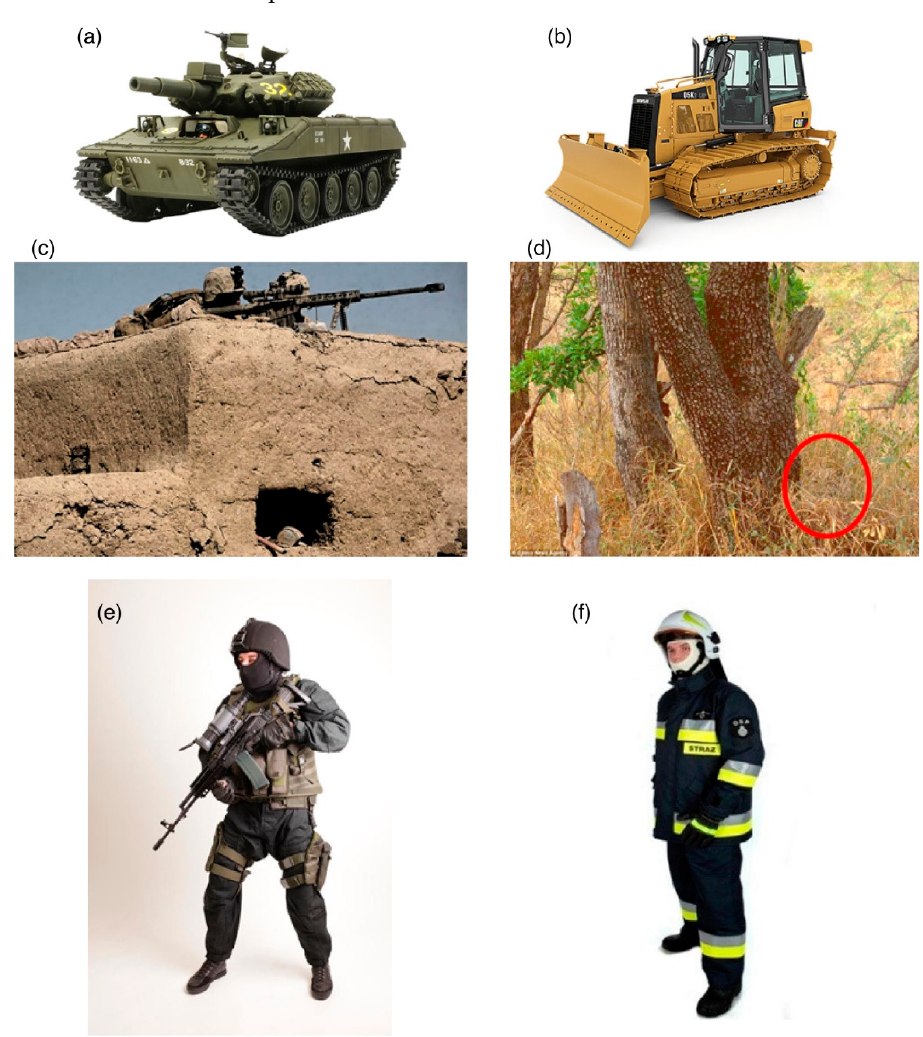
Figure 2. Examples of stimuli associated with the military ( a,c,e ) and distractors ( b,d,f ).